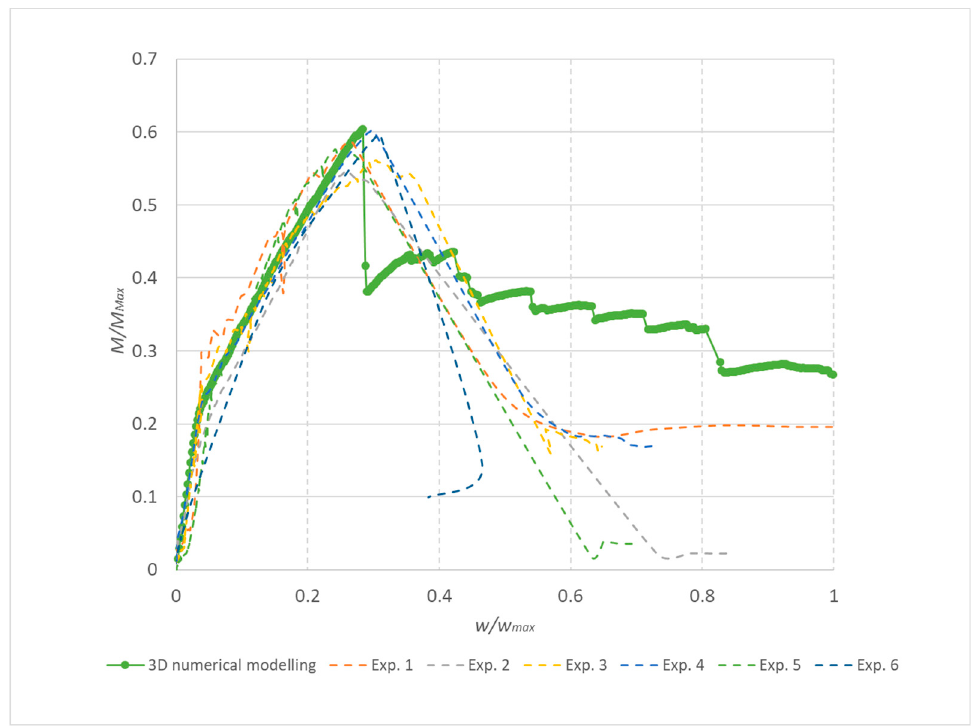
Figure 14. Results for reinforced concrete beams without transverse reinforcement, reinforcement 10 mm: Experiment 1–6 and 3D model.